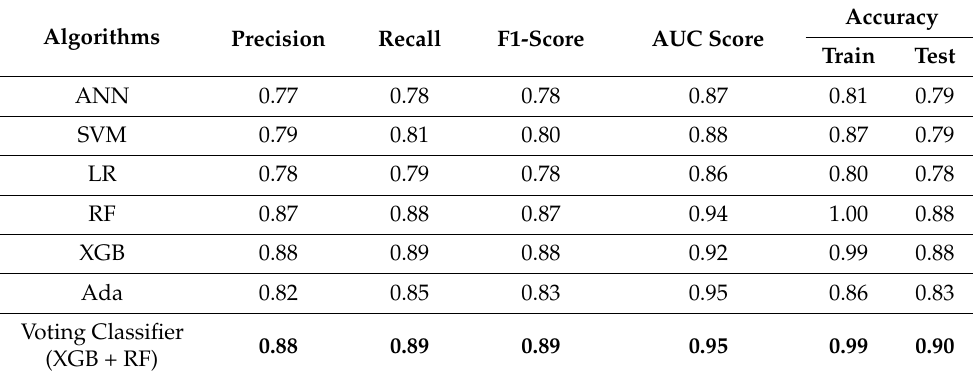
Table 5. All models’ performance for the five-fold cross-validation of the dataset with the bal- anced